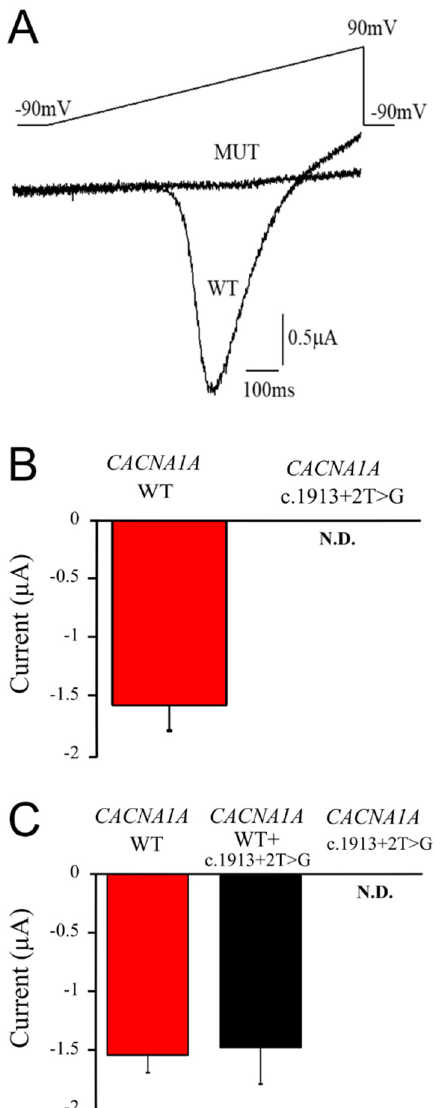
Figure 5. The mutation causes the total loss of function of the Cav2.1 channels. ( A ) Overlaid representative current traces recorded from a Xenopus laevis oocyte injected with wild-type or mutant cDNA for Ca V 2.1 and auxiliary subunits. Currents were elicited by a depolarizing ramp from –90 mV to +90 mV, lasting 1 s in duration. ( B ) Bar plot showing the peak whole-cell current amplitudes for the indicated channels. Notice that membrane currents could not be detected (N.D.) in any of the cells injected with mutant cDNA. ( C ) Bar plot showing the peak whole-cell current amplitudes recorded from oocytes injected with wild-type Cav2.1, co-injected with mutant cDNA (1:1 ratio), or injected with mutant cDNA, together with the accessory subunits . Three different batches of oocytes were collected, and the recorded currents were averaged (data are mean ± SE; for panel B, n = 30 for wild-type; n = 44 for mutant; for panel C, n = 36 for wild-type; n = 26 for wild-type + mutant; n = 59 for mutant; the statistical analysis of graph B revealed a significance of p < 00001, whereas the data reported in graph C were not statistically significant except for the mutant alone).